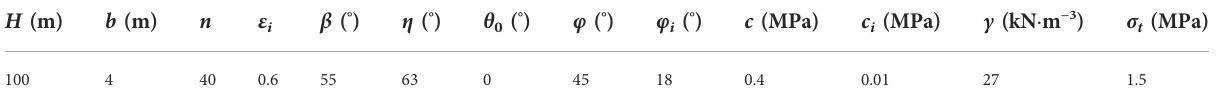
TABLE 1 Softened parameters of rock mass of Yangtai slope (Liu,